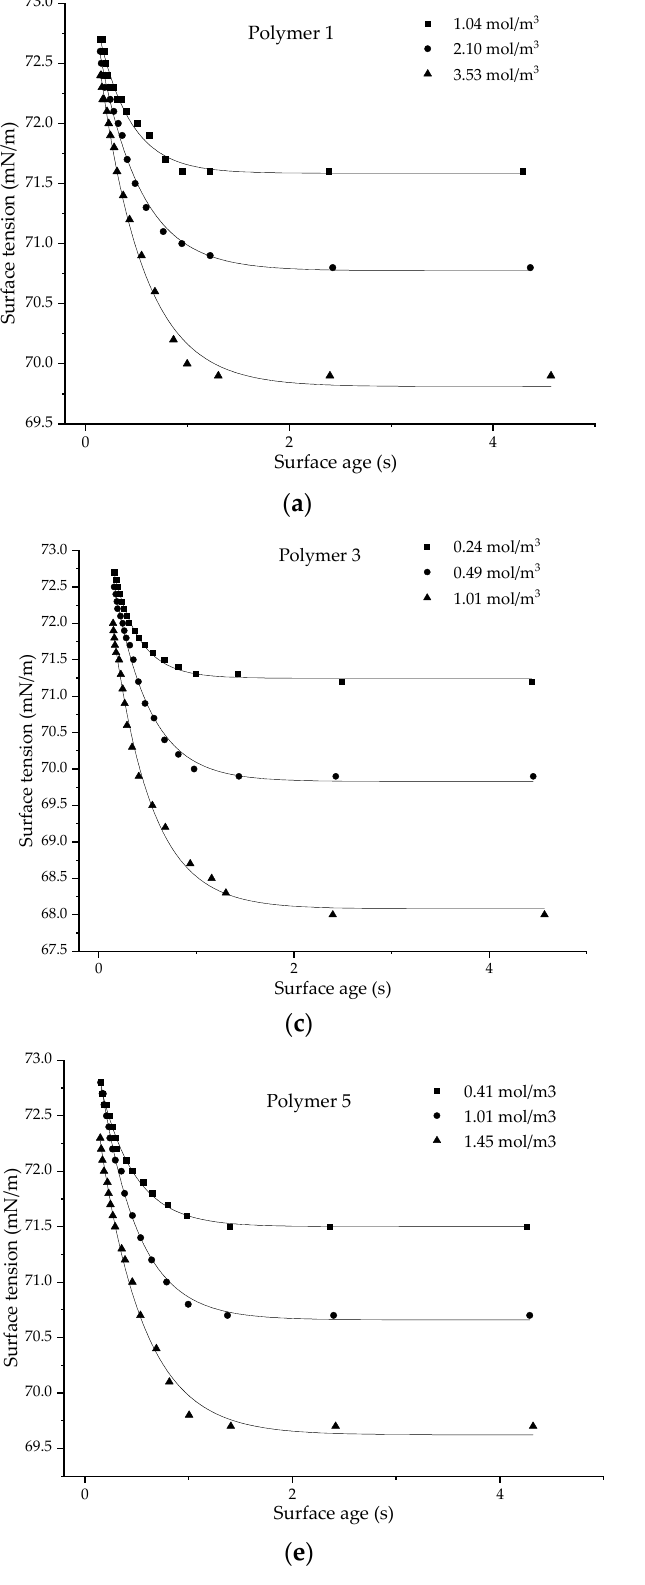
Figure 11. Dynamic surface tension (mN/m) at different concentrations (mol/m 3 ) for CUP particles made from polymers 1–5 ( a – e ).